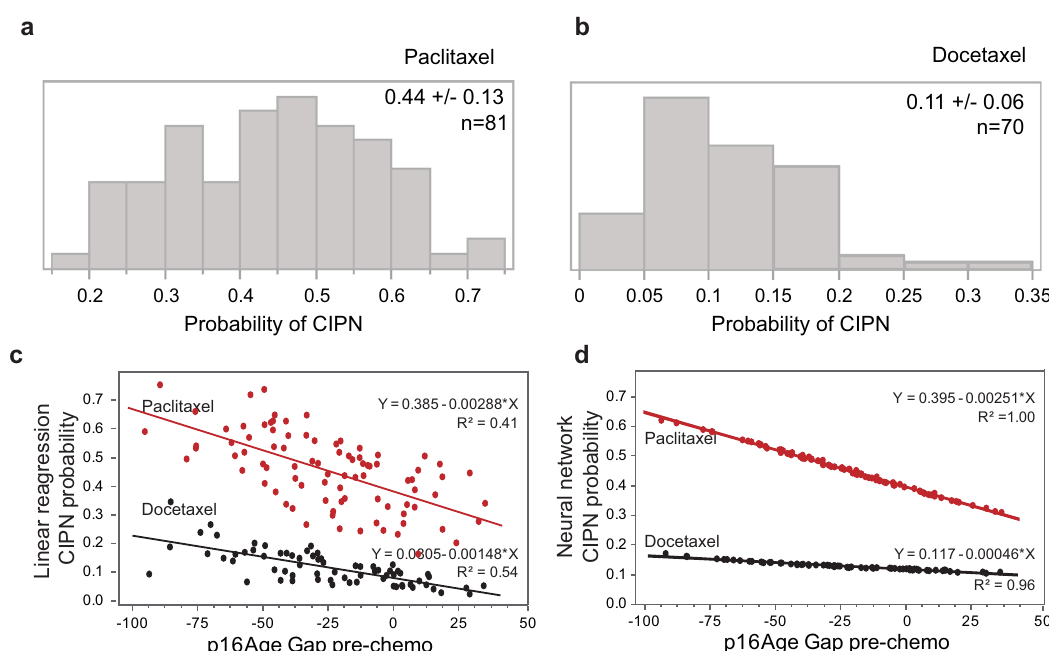
Fig. 2 Correlation between p16Age Gap and probability of CIPN. Probability of developing grade 2 + CIPN, calculated from the linear regression Model 2 in participants receiving paclitaxel ( a ) or docetaxel ( b ) chemotherapy is shown in a histogram. Correlation between p16Age Gap single variable and a probability of CIPN derived from linear regression ( c ) or neural network ( d ) based model demonstrates signi fi cant contribution of p16Age Gap alone to the model.